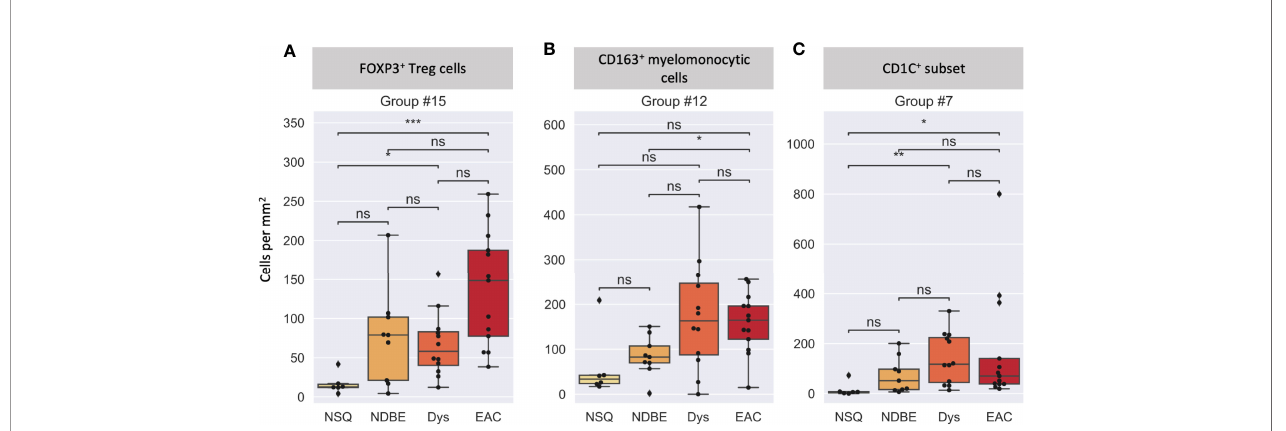
FIGURE 7 | Cell density per mm2 at different disease stages of selected cell groups that clustered by SSC. (A) Group #15 was interpreted as FOXP3+ Treg cells, (B) Group #12 was interpreted as a CD163+ myelomonocytic cells (CD163 + CD68 + ), and (C) Group #7 was interpreted as a new CD1C+ subset (CSF1R + CD1C + ), please also see Figure 6 . Each datapoint represent one ROI. Statistics: Mann-Whitney-Wilcoxon test two-sided with Bonferroni correction: ns (not signi fi cant): p > 0.05; *p ≤ 0.05; **p ≤ 0.01, ***p ≤